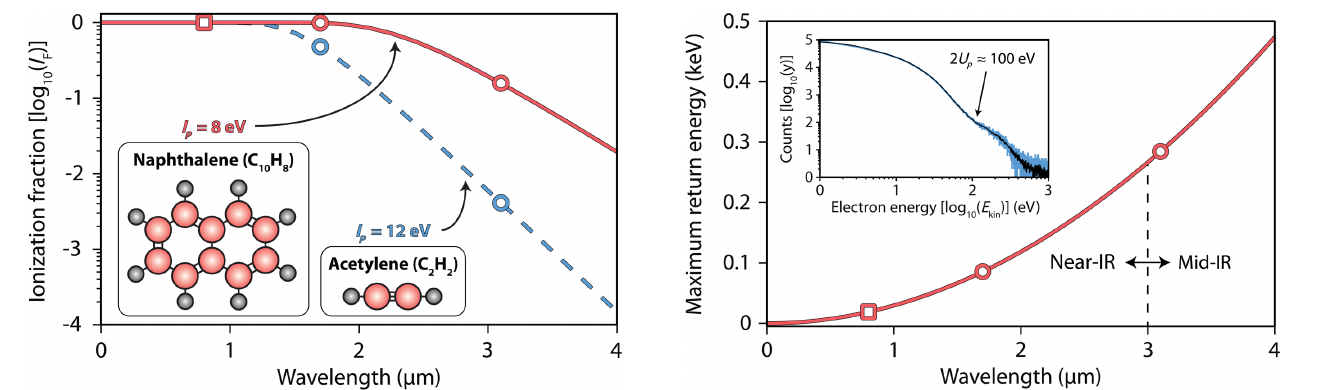
FIG. 2. The ionization fractions calculated at the peak of a six-cycle pulse for targets with different ionization potentials while keeping the Keldysh parameter constant at γ ¼ 0 . 3 . The squares represent 0 . 8 - μ m radiation while the circles are the wavelengths of our OPCPA.